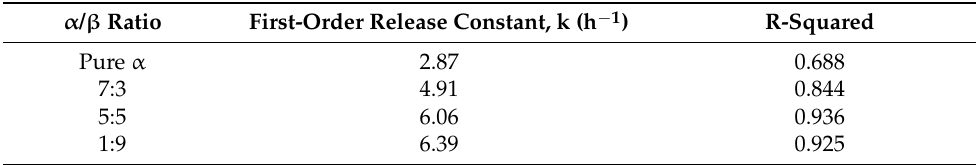
Table 2. The fitting parameters for the release profiles using the first-order release model. α / β